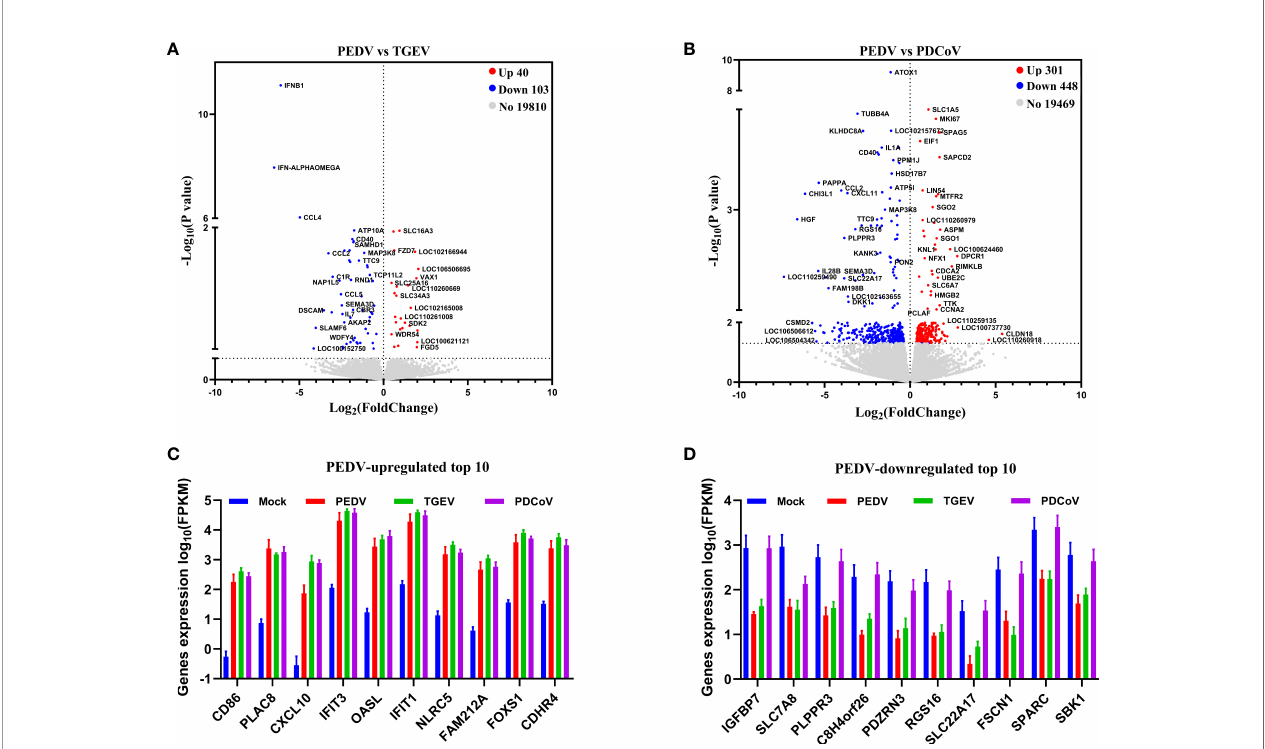
FIGURE 3 | PEDV and TGEV, not PDCoV, exert a similar effect on the biological function of porcine enteroids. (A, B) Volcano plot of all expressed host genes of PEDV-infected enteroids relative to TGEV-infected enteroids (A) and PDCoV-infected enteroids (B) . The y-axis shows the -log 10 transformed P-value, and the x-axis shows the log 2 fold change in normalized expression; the red, blue, and gray points represent the signi fi cantly upregulated, downregulated, and non-signi fi cant differentially expressed genes, respectively ( P < 0.05). (C, D) The transcriptional expressions of PEDV-elicited top 10 signi fi cantly upregulated (C) or downregulated (D) genes in the three SECoVs-infected enteroids were evaluated based on log(RPKM) values (n =